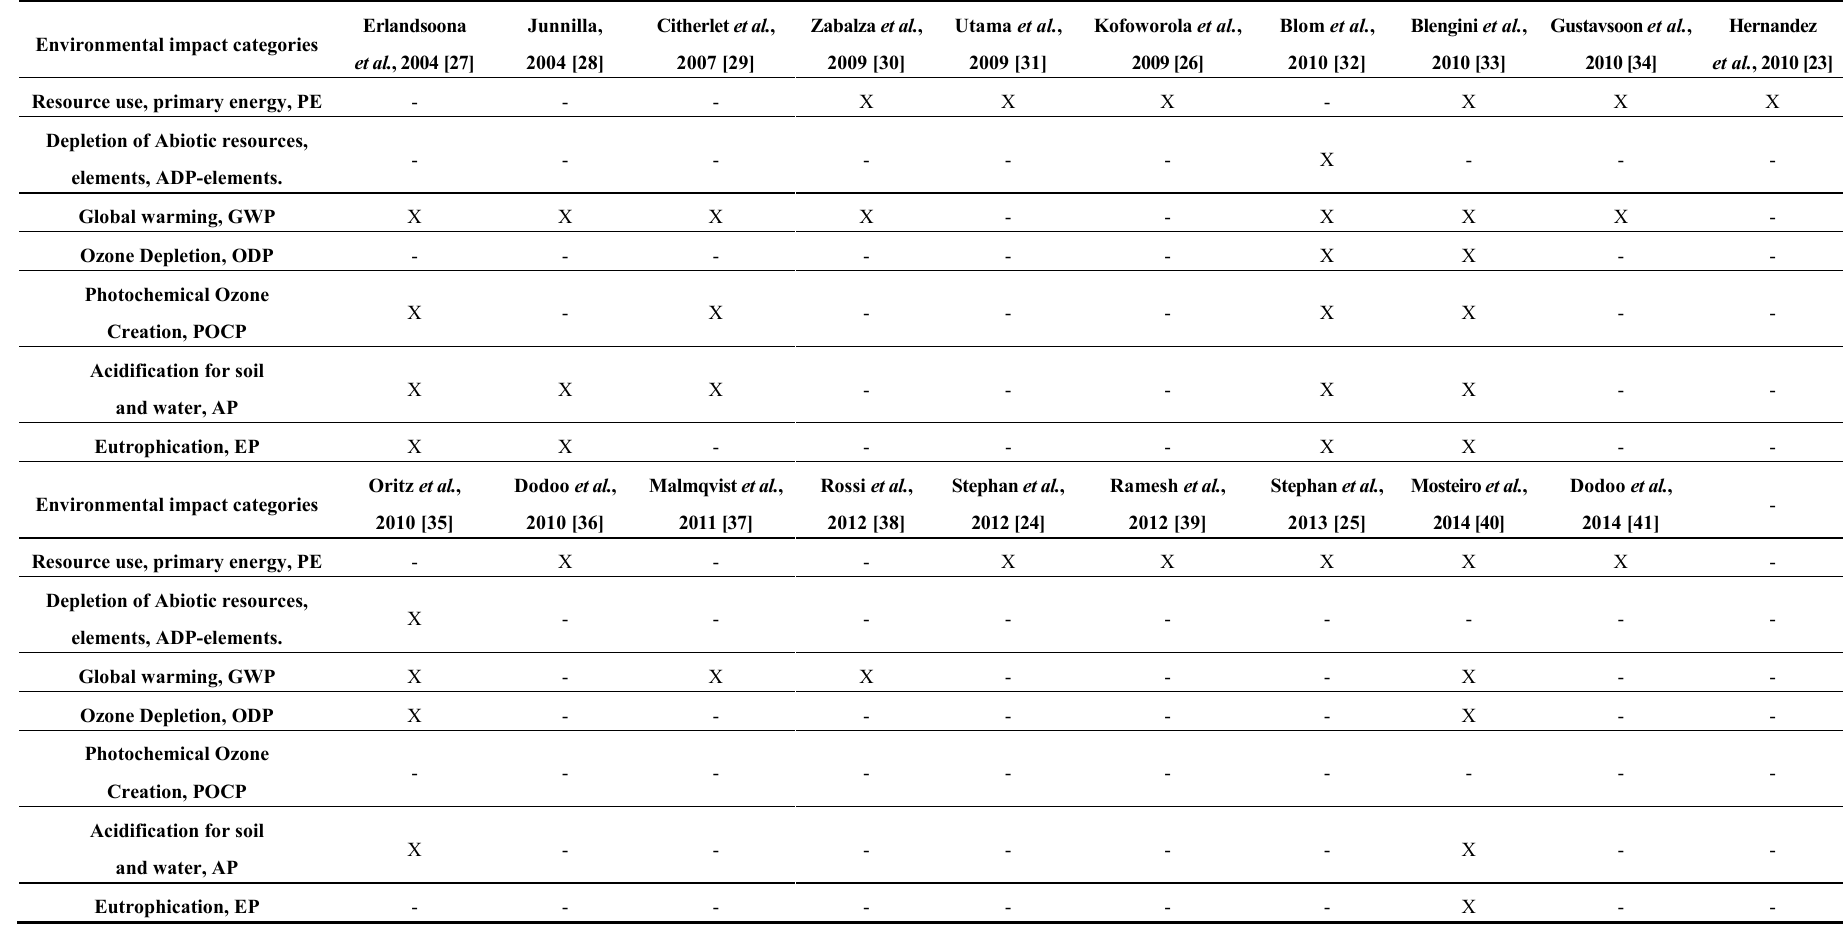
Table 9. Environmental impact categories used in previous